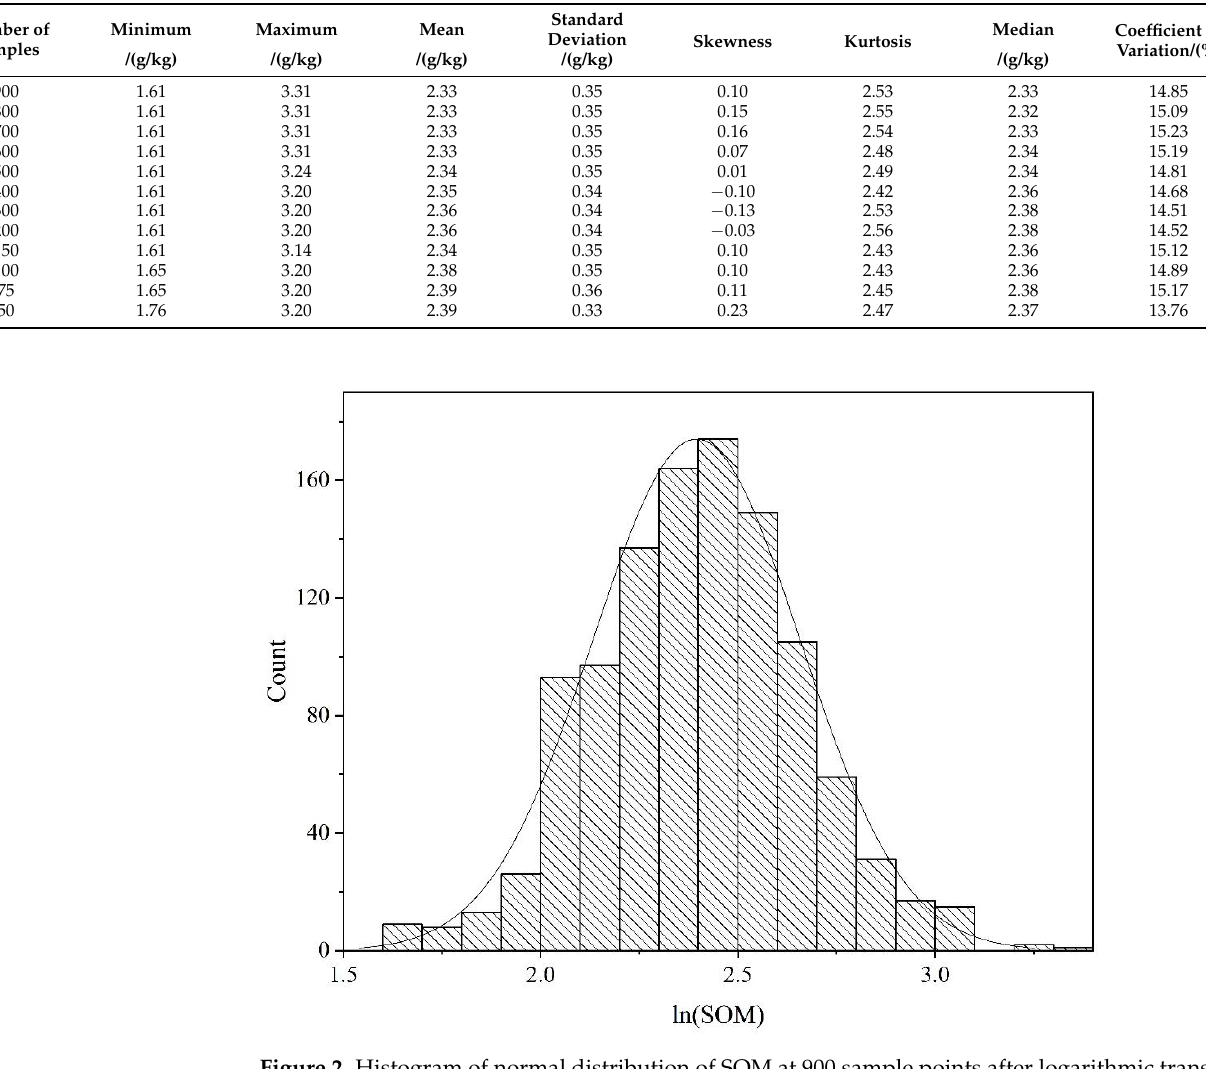
Table 2. Descriptive statistics of SOM content after logarithmic transformation.